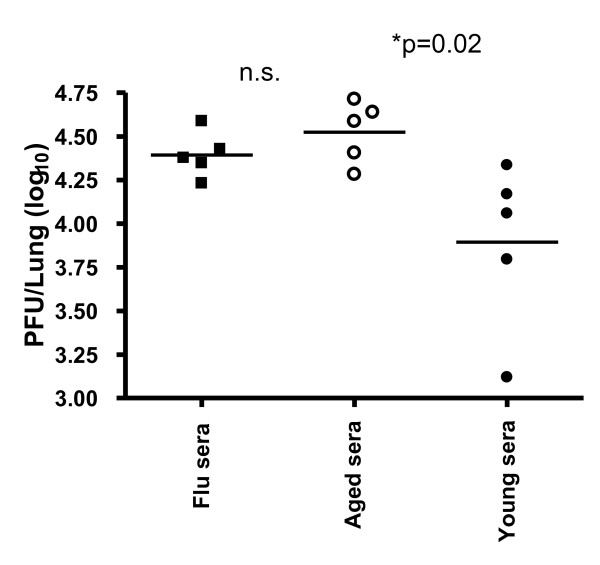
Sera from aged mice is less protective in vivo against acute γHV68 infection. One hundred microliters of sera from young (3 months p. i.) or aged (22 months p. i.) γHV68-infected animals was injected intravenously into naïve C57BL/6 mice one day prior to intranasal γHV68 infection (400 PFU). Control mice received convalescent sera from influenza virus-infected mice. Symbols represent lung viral titers measured in individual mice at 5 days post infection using a standard plaque assay. Bars indicate the medians calculated from the data shown. Significance was assessed using the Mann-Whitney rank test (two-tailed, 95% confidence). Ns; not significant